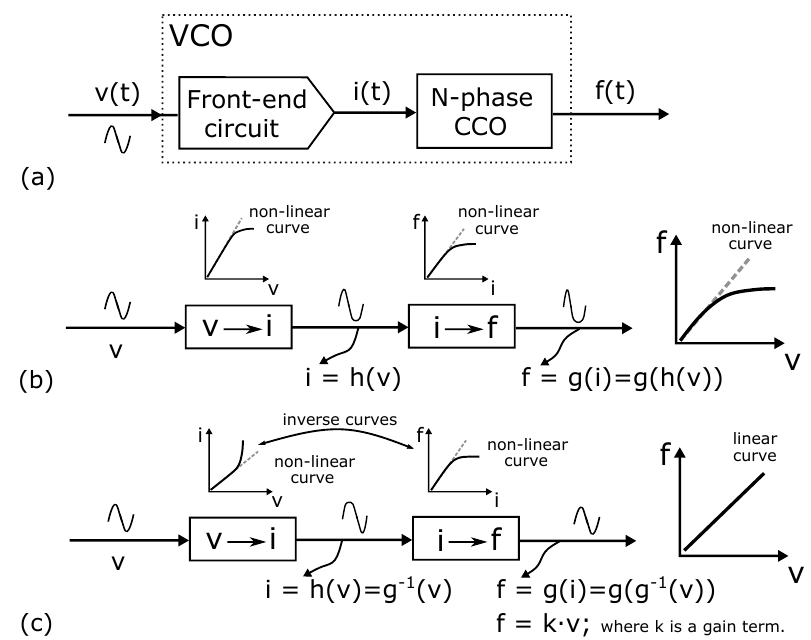
Figure 1. ( a ) General scheme of a VCO; ( b ) nonlinear VCO operation; and ( c ) proposed lineariza- tion